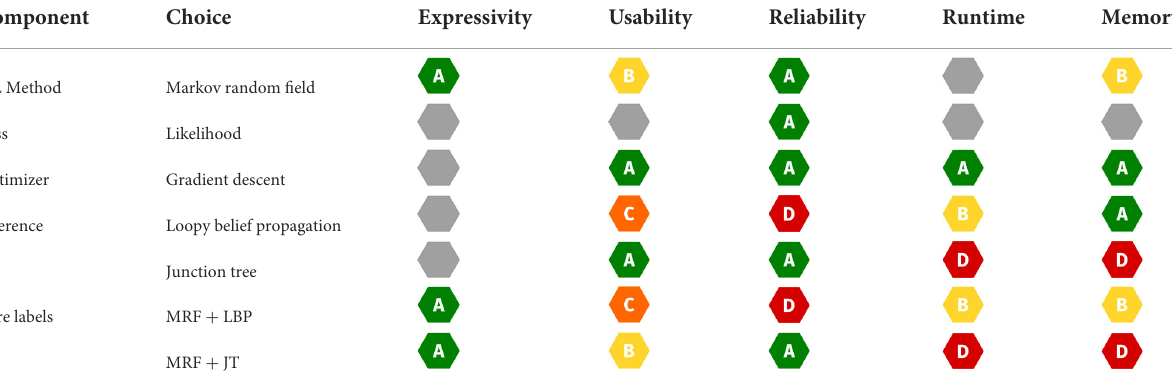
TABLE 3 Ratings for individual components based on theoretical properties and expert knowledge rated from A to D alongside the final combined ratings for two concrete configurations. Component